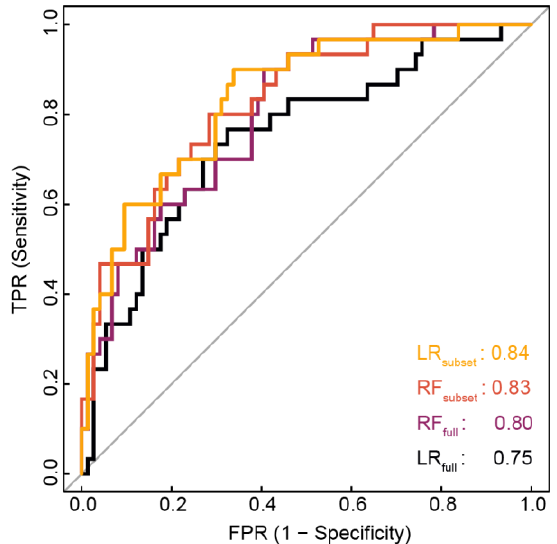
Figure 8. Receiver operation characteristic (ROC) curves for random forest (RF) and logistic regression (LR) models on rock glacier activity, based on either a full parameter set or a parameter subset (noted in subscript, see Table 2). Model performance metrics are given as the area under the ROC curve (AUC). TPR = true positive rate; FPR = false positive rate.